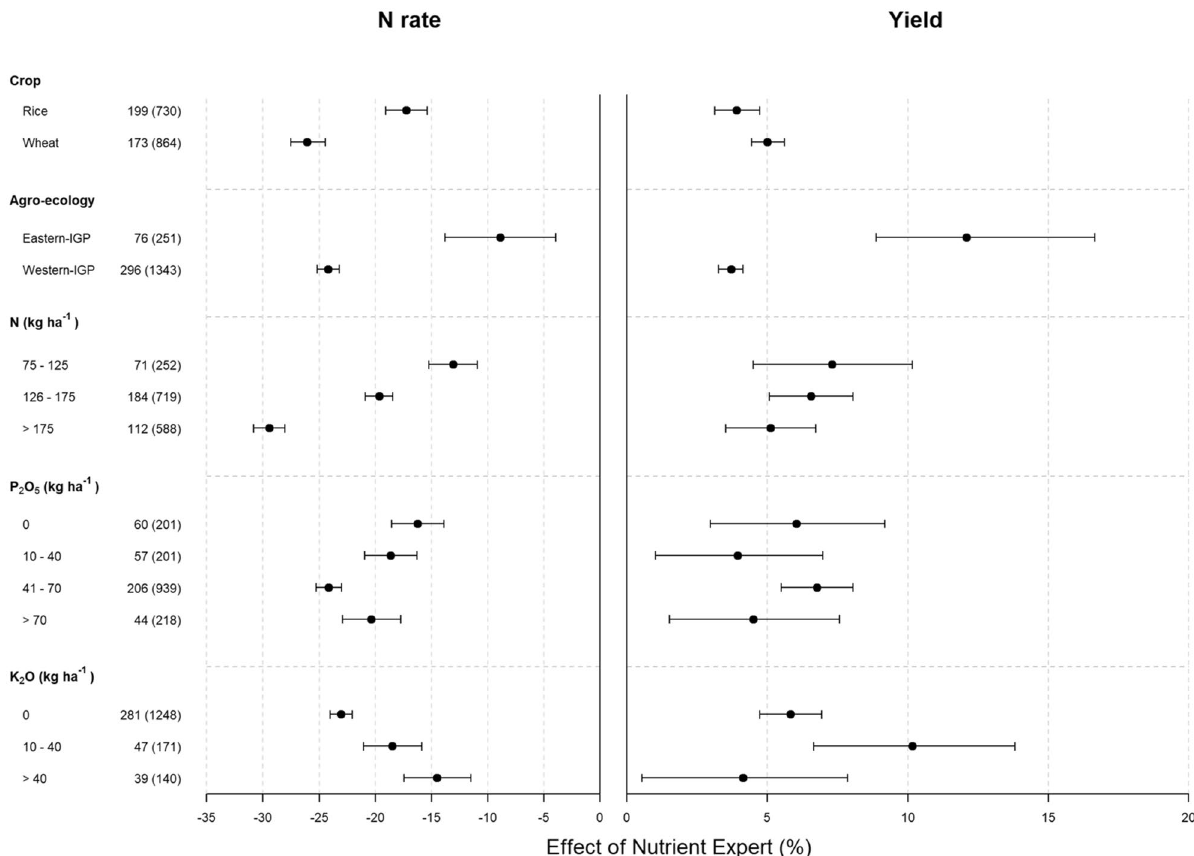
Figure 2. Percent change in nitrogen use rate (left panel) and grain yields (right panel) due to NE-based fertilizer management compared to FFP segregated by crop types, agro-ecological zones and farmers’ fertilizer application rates. In the Y-axis, the numbers outside parentheses denote the number of villages and the ones inside parentheses show the number of pairs analyzed. Error bars indicate 95% confidence intervals (CI). The changes are considered significant when 95% CI does not overlap zero, and the effects of categories within a parameter are significantly different when their 95% CI do not overlap with each other. IGP = Indo-Gangetic